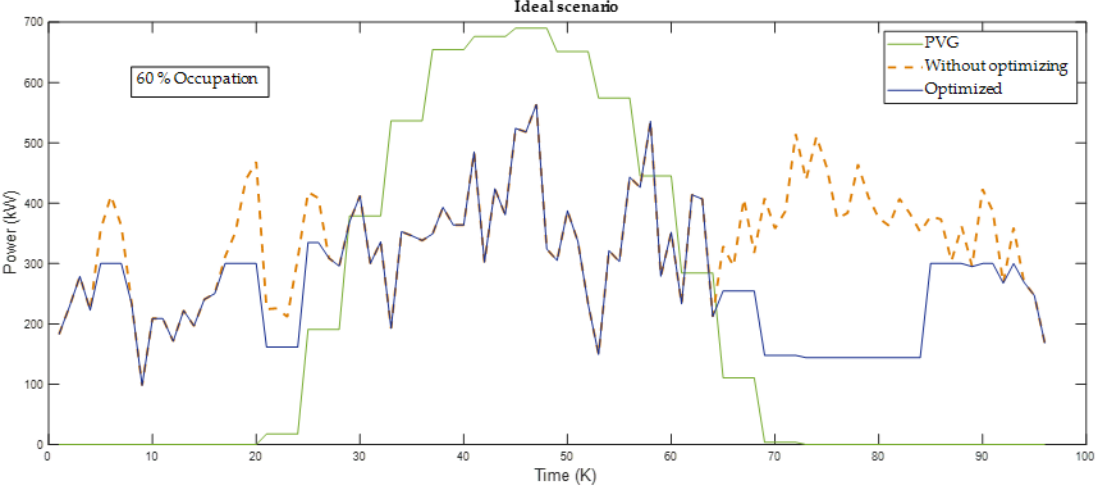
Figure 16. Demand optimization in the 60% scenario (real and ideal load patterns).